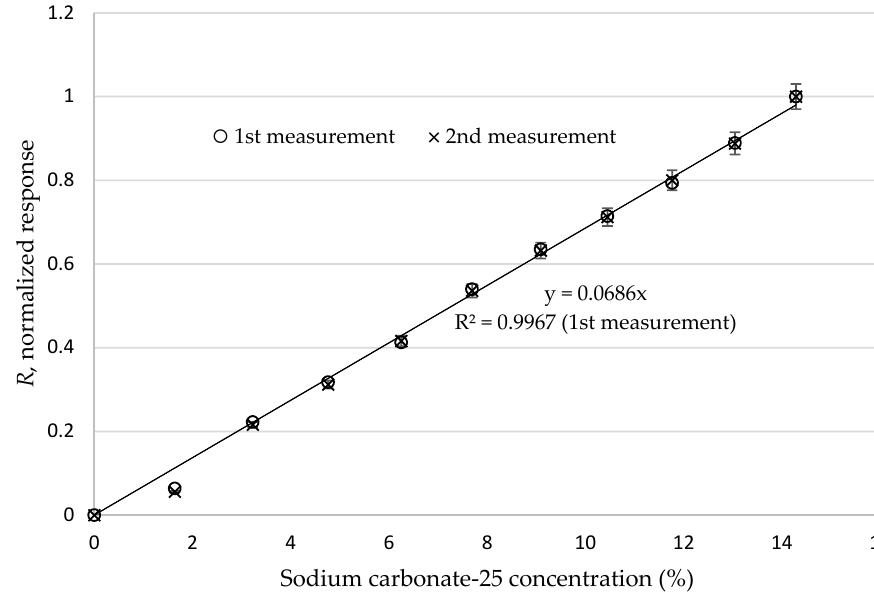
Figure 5. Normalized response of P-233 against percentage concentration (error bars represent less than 3% error for the measurements).